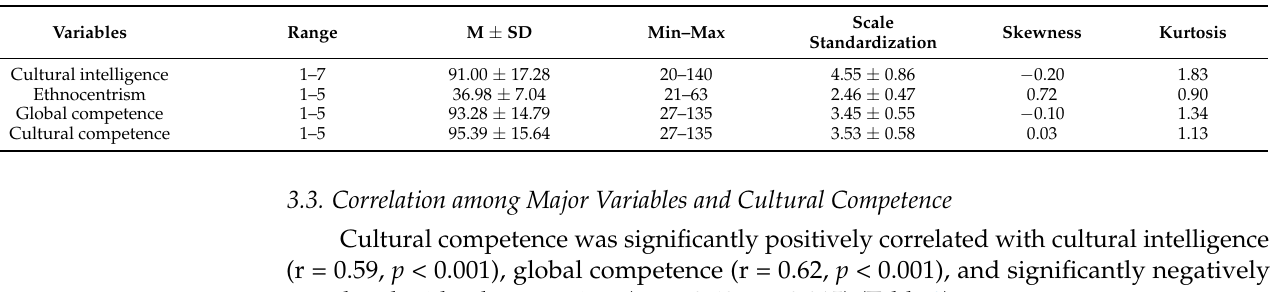
Table 2. Scores of cultural intelligence, ethnocentrism, global competence, and cultural competence (N = 235).